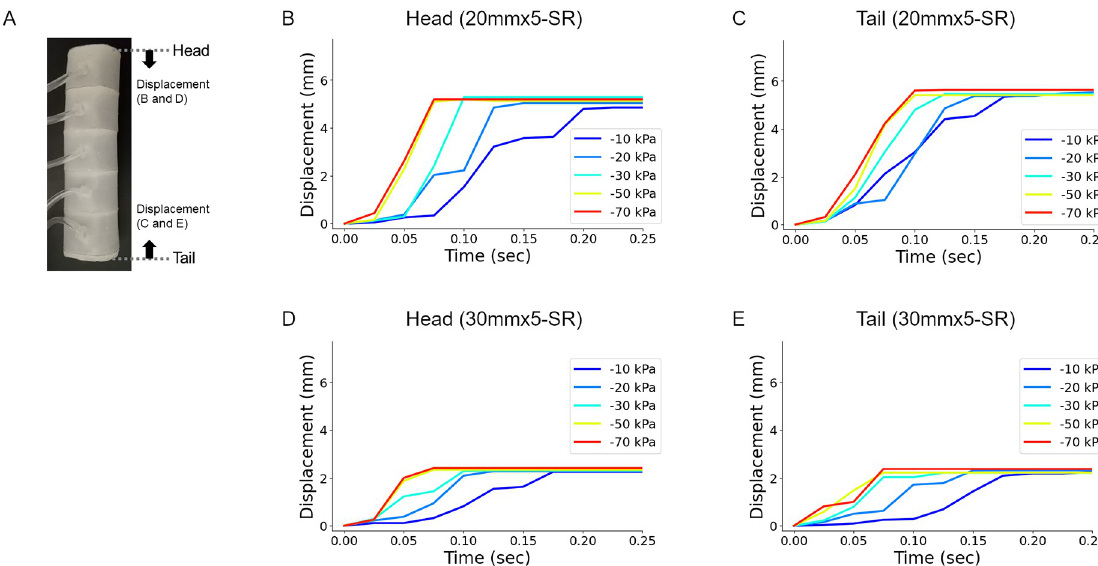
Fig 7. Deformation of the terminal segments of the soft robots by pneumatic control. (A) The displacements of the head and tail of the soft robots were monitored. (B-C) Displacements of the head (B) and tail (C) of the 20mmx5 soft robot by pneumatic control of the corresponding segment (head or tail segment). (D-E) Displacements of the head (D) and tail (E) of the 30mmx5 soft robot by pneumatic control of the corresponding segment (head or tail segment). The internal pressures were tested from -70 kPa to -10 kPa.